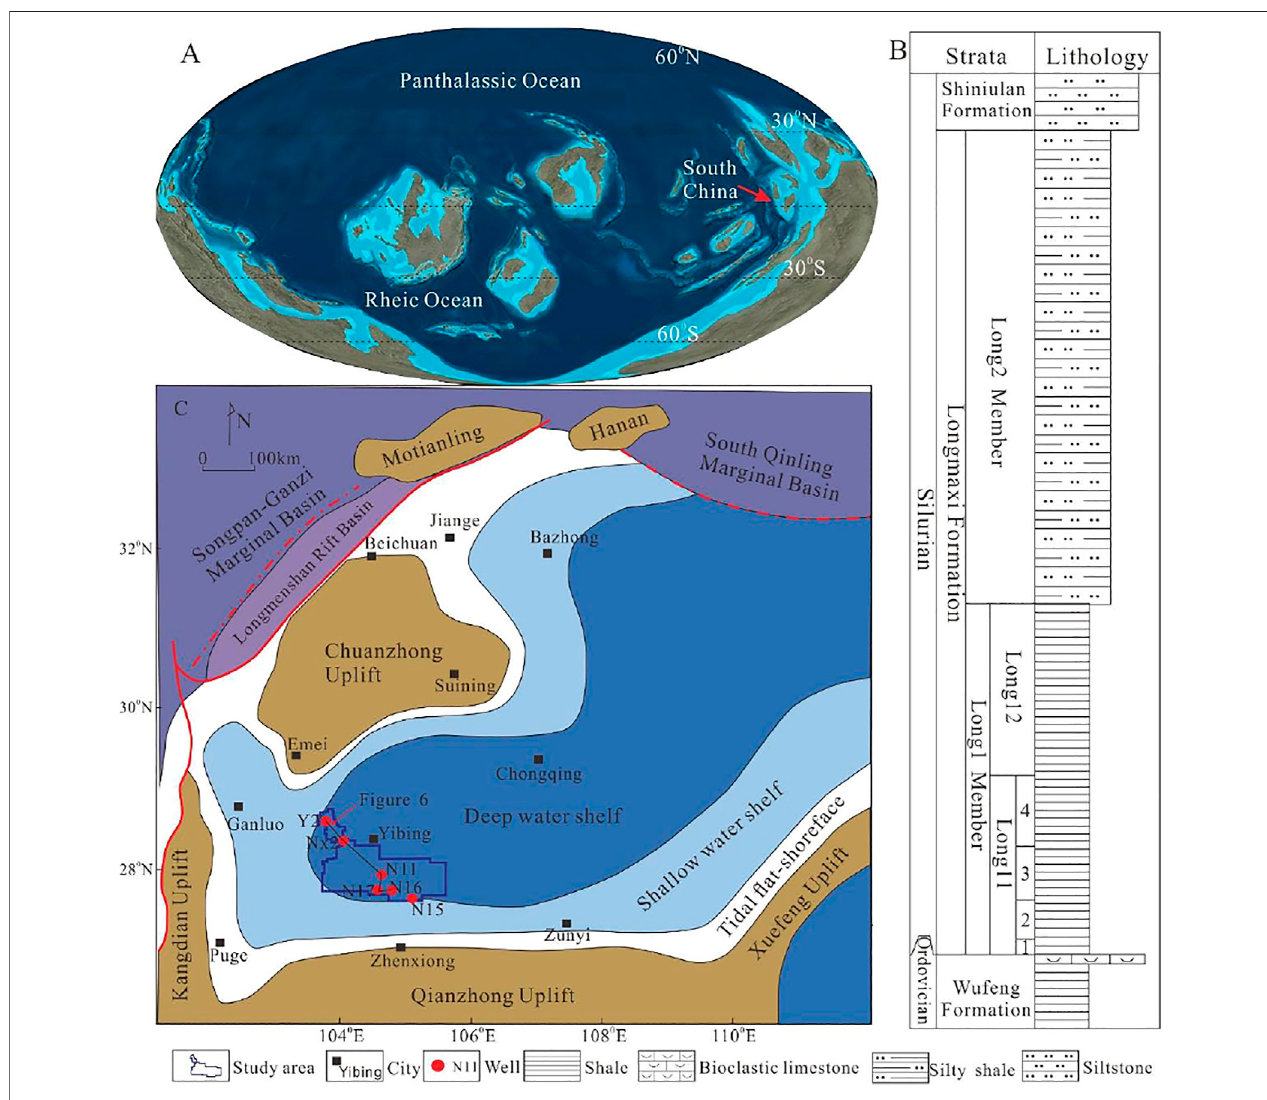
FIGURE 1 | (A) Global paleogeography during the Early Silurian (Yan et al., 2021). (B) Lithologic column of the Upper Wufeng Formation to the Lower Silurian Longmaxi Formation in the Changning area, south Sichuan Basin. (C) Paleogeographic map of the Yangtze area and location of the Changning area (modi fi ed from Huang et al., 2018; Chen et al., 2019; Yan et al., 2021).